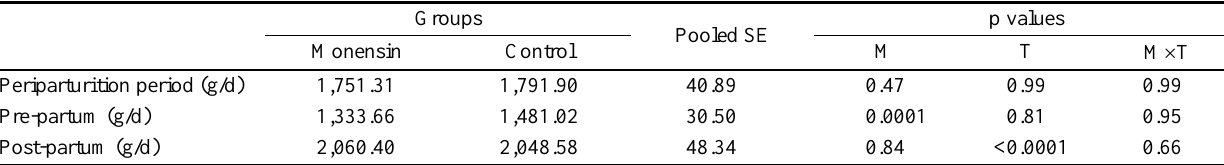
Table 2. Comparison of least square of means (LSMs) and standard errors (SE) of dry matter intake between Saanen does receiving monensin and the controls which did not received it Groups p values Pooled SE Monensin Control